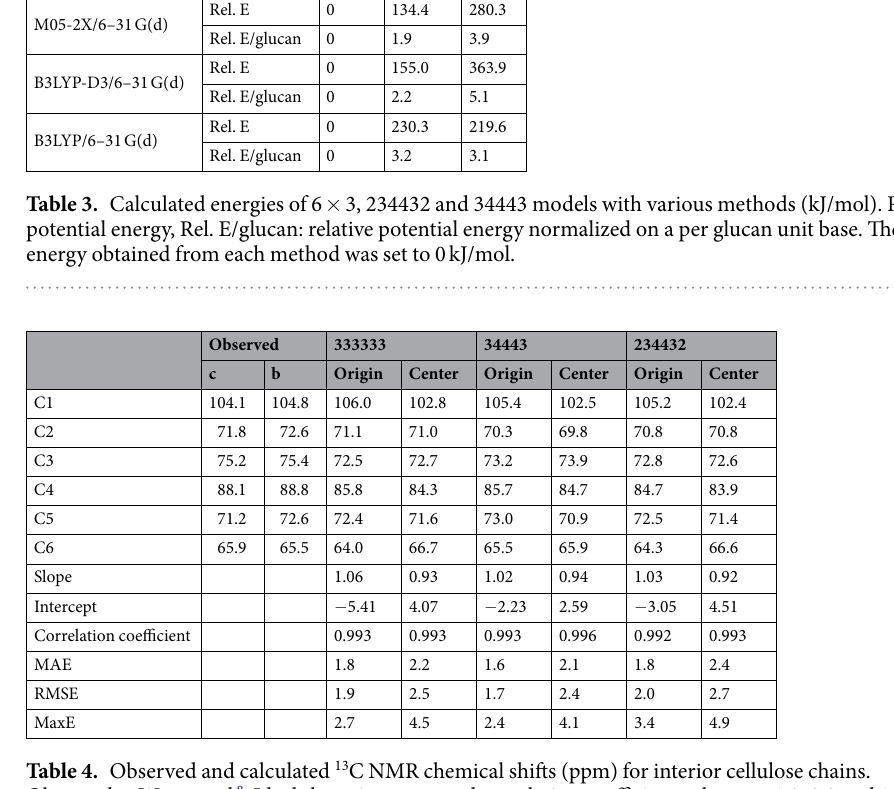
Table 4. Observed and calculated 13 C NMR chemical shifts (ppm) for interior cellulose